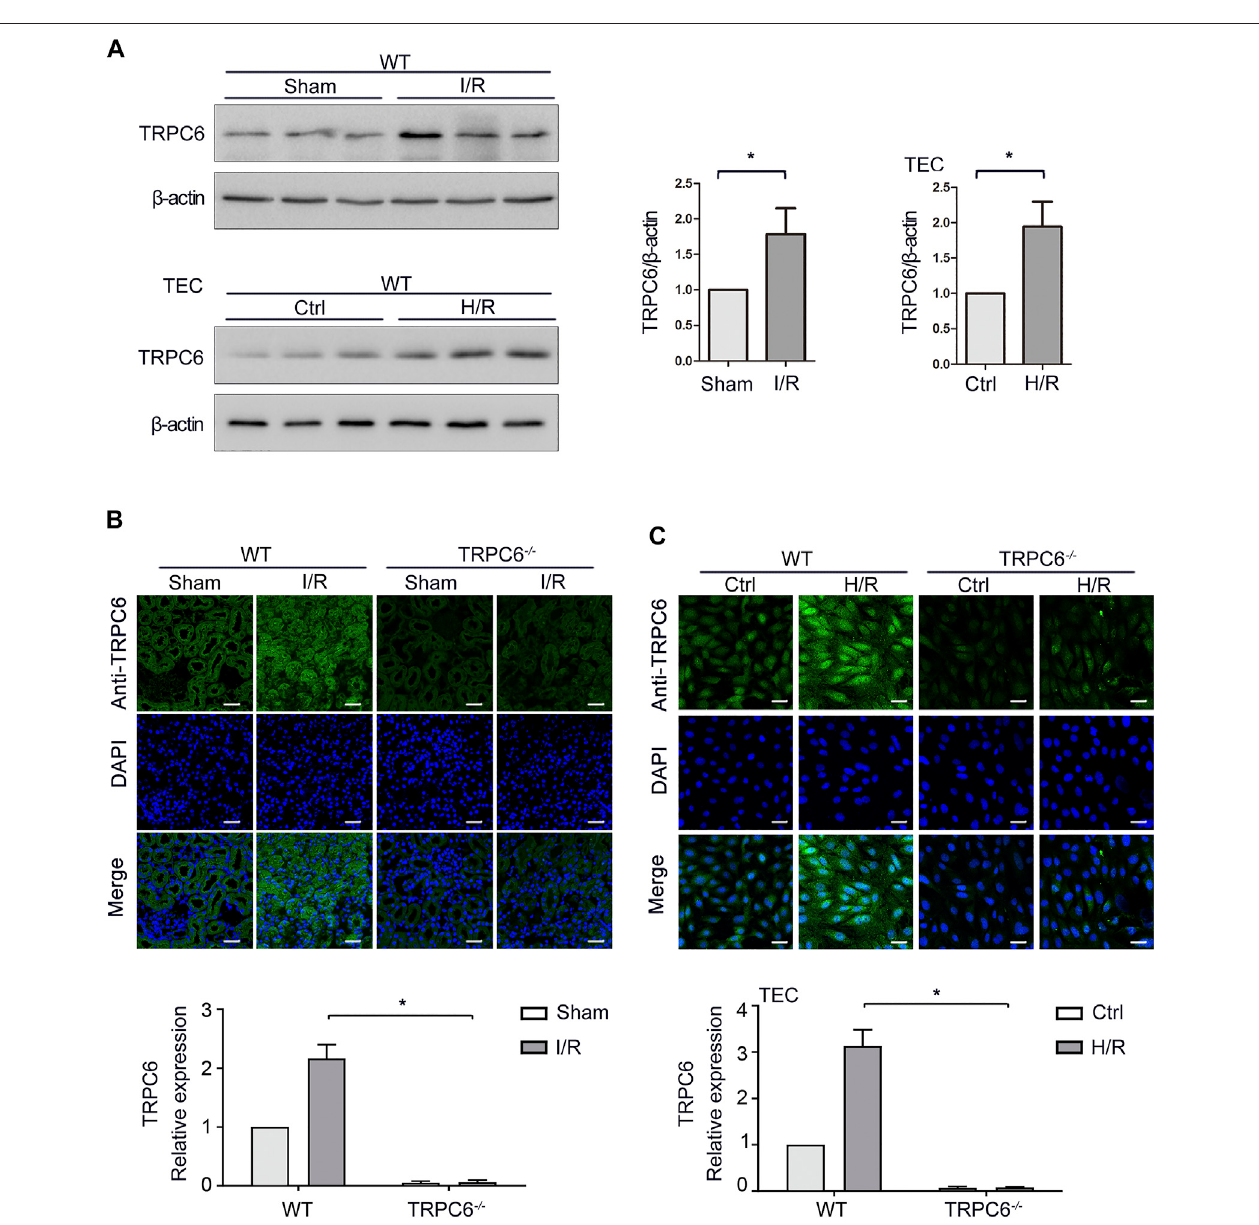
FIGURE 1 | Increased expression of TRPC6 after I/R and H/R injuries. (A) Representative western blot images of TRPC6 in renal tissue lysates of WT-sham and WT-I/R and TEC lysates of WT-H/R treatment. Bars represent mean ± SEM, n (cid:2) 3, * p < 0.05. (B) Representative confocal microscopy images of TRPC6 expression in kidney sections from WT and TRPC6 − / − mice subjected to sham or I/R operations (photographed at a magni fi cation of × 200, scale bar: 50 μ m). Bars represent mean ± SEM, n (cid:2) 6, * p < 0.05. (C) Representative confocal microscopy images of TRPC6 expression in primary TECs from WT and TRPC6 − / − mice upon H/R treatment (photographed at a magni fi cation of × 200, scale bar: 50 μ m). Bars represent mean ± SEM, n (cid:2) 6, * p <